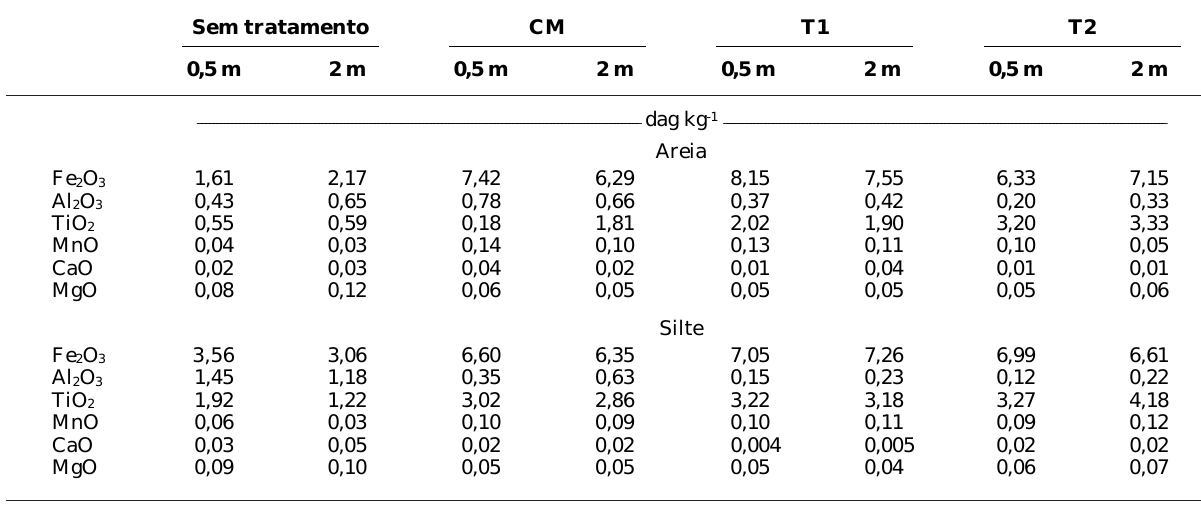
Quadro 2. Resultado da análise dos elementos com maiores teores, das amostras coletadas a 0,5 e 2 m de profundidade, das frações areia e silte, antes de qualquer tratamento e após concentração